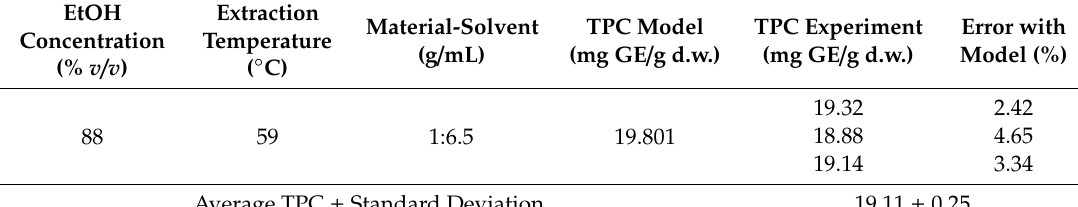
Table 5. The result of optimum point experiment.